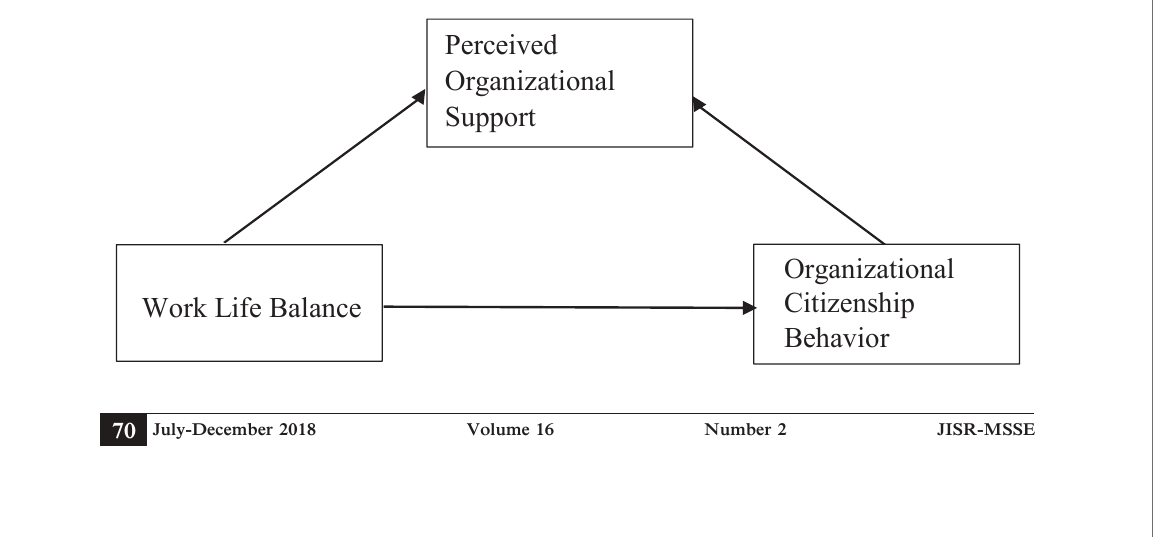
Perceived Organizational Support